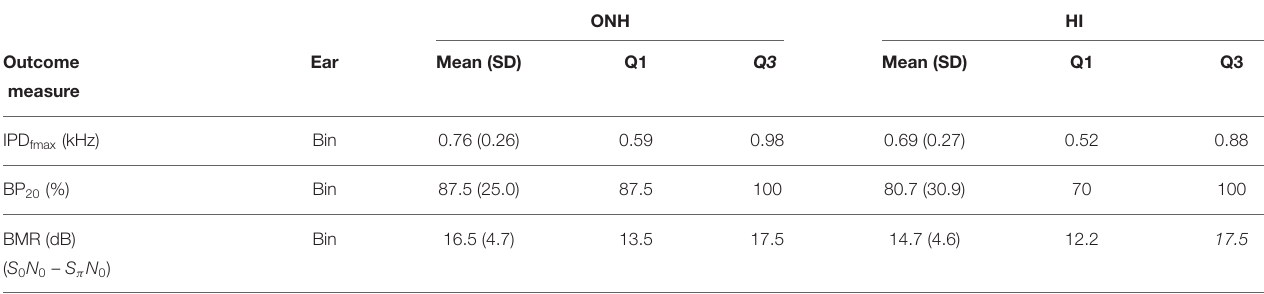
TABLE 10 | Summary of the results of the binaural processing abilities tests.